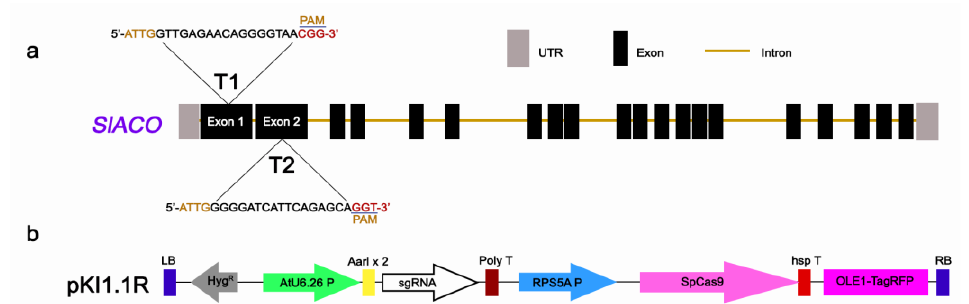
Figure 2. CRISPR/Cas9-mediated genome editing of SlACO2 gene ( a ) Schematic illustration of the two target sites in SlACO2 genomic sequence. Target 1 and Target 2 sequences are shown in capital letters, and the protospacer adjacent motif (PAM) sequence is marked in red. ( b ) Schematic diagram of Cas9/sgRNAs expression vector (pKI1.1R) used for Agrobacterium-mediated transformation of tomato.